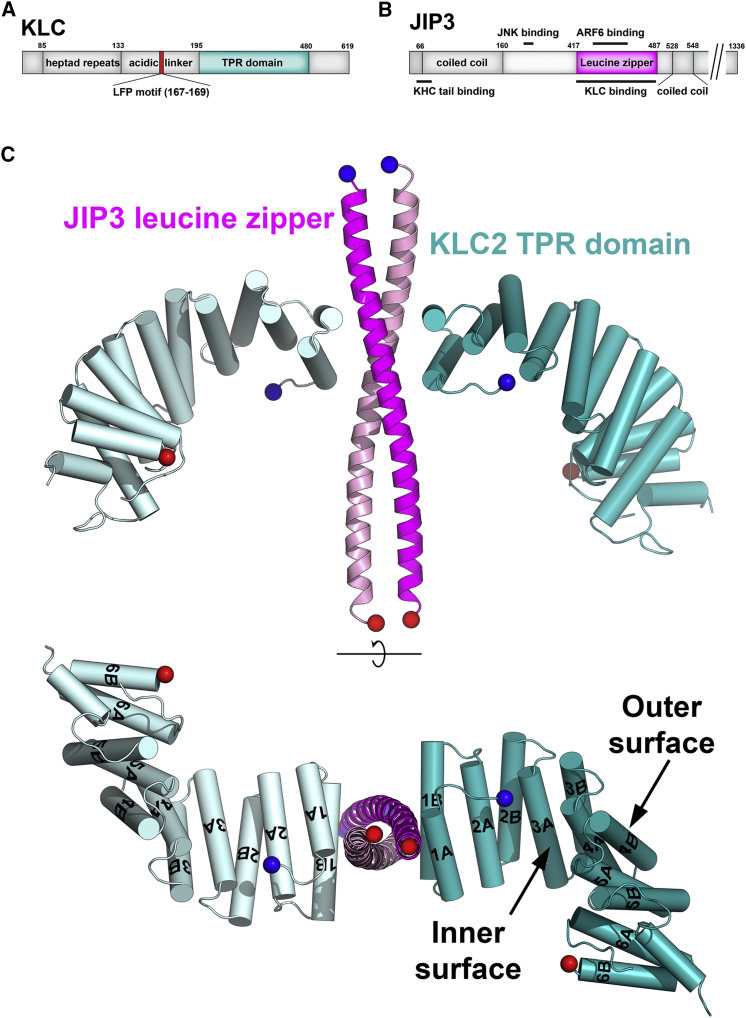
The Crystal Structure of the KLC2TPR:JIP3LZ Complex(A and B) Schematics of the KLC2 (A) and JIP3 (B) molecules.(C) The KLC2TPR:JIP3LZ complex. The KLC2TPRs are shown in teal (chain A) and cyan (chain B). The KLC2TPR α helices are shown as cylinders and labeled 1A through 6B. JIP3LZ subunits are shown in magenta (chain C) and pink (chain D) cartoon. Blue/red spheres are N- and C-terminal Cα atoms, respectively.See also Figure S1.